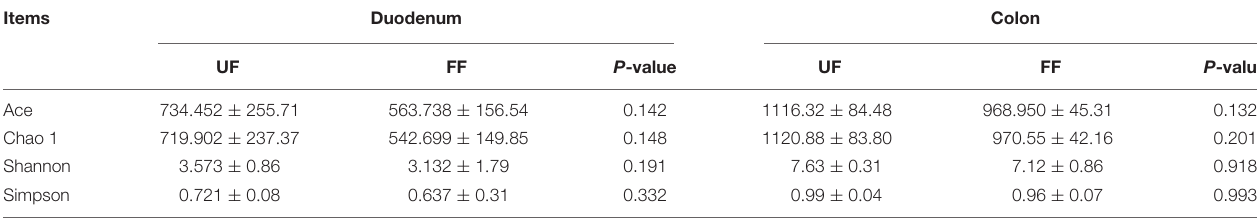
TABLE 4 | Diversity estimation of the 16S rRNA gene libraries from microbiota in the duodenum and colon of pigs fed the control UF and FF meals.